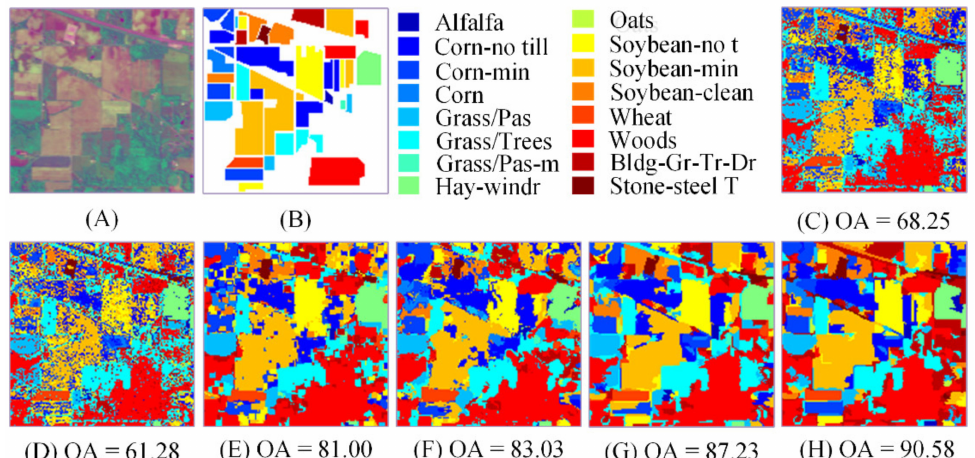
Figure 4. Indian Pines image: ( A ) composite color image and ( B ) ground truth; estimation map obtained by ( C ) SVM; ( D ) SRC; ( E ) JSRC; ( F ) NLW-JSRC; ( G ) SP-JSRC; ( H ) SNLW-JSRC.